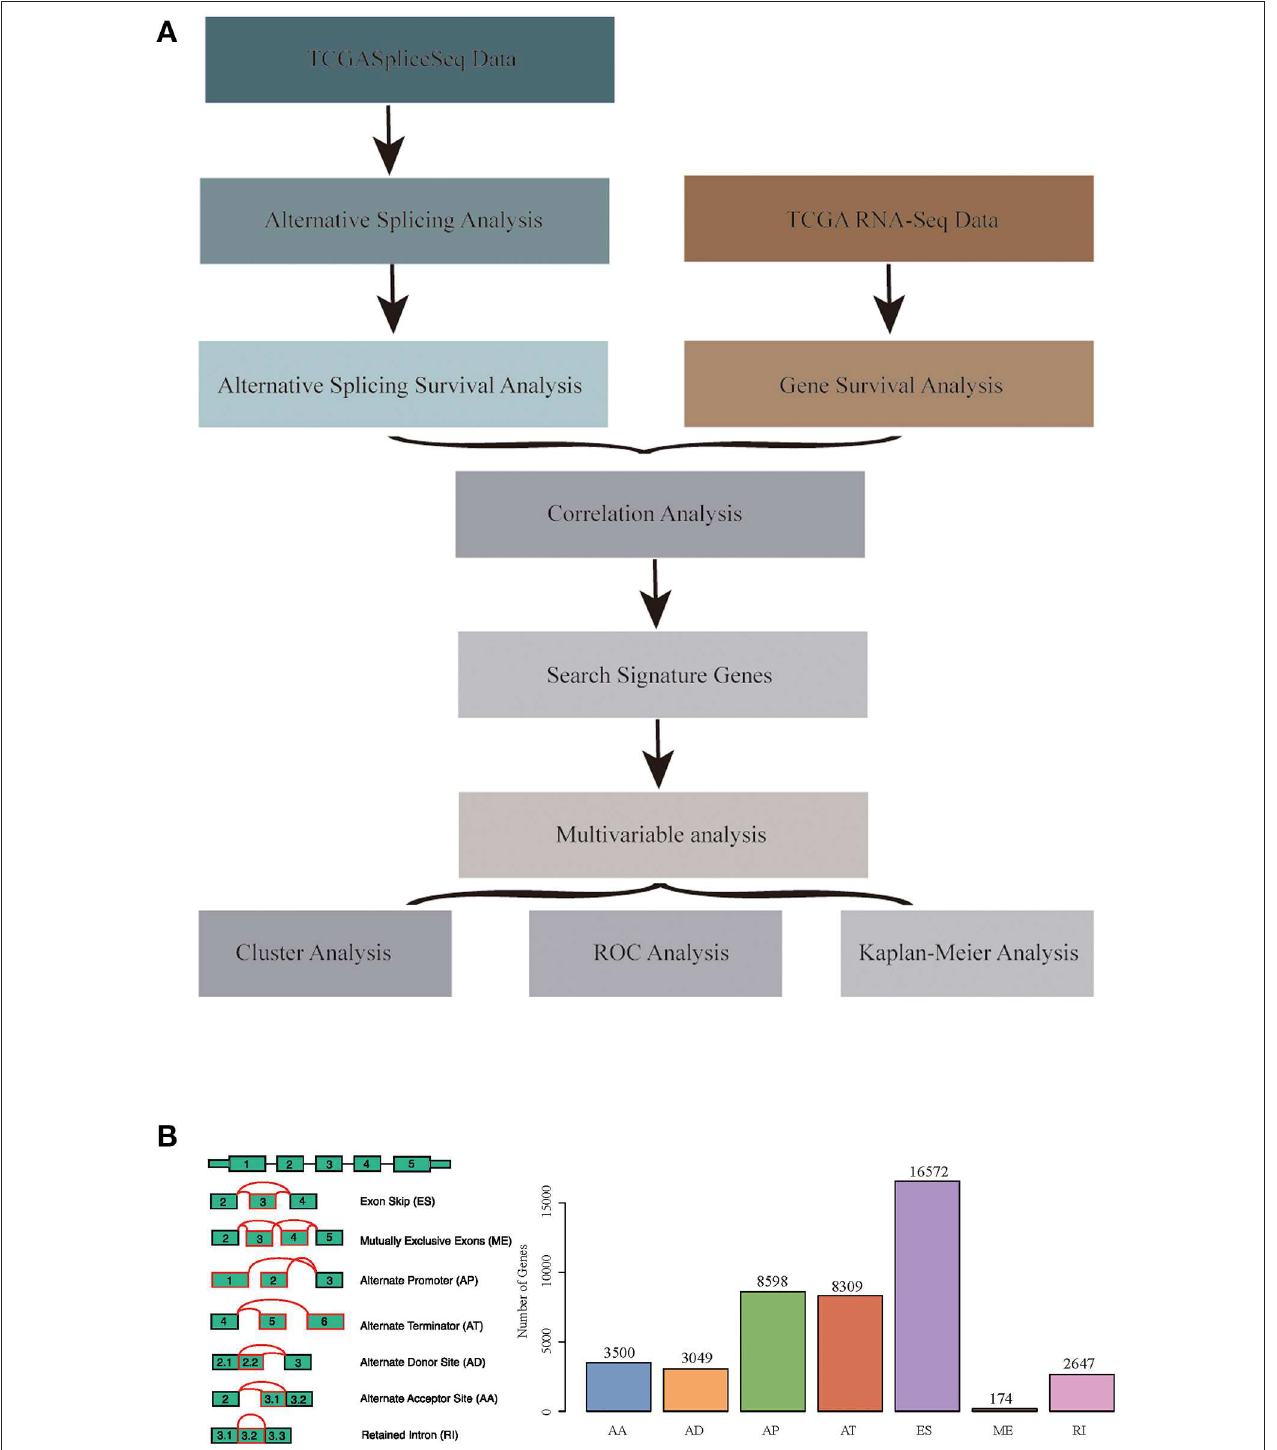
FIGURE 1 | (A) Schematic diagram of the research methodology. (B) Overview of seven types of alternative splicing (AS) events in this study. Illustrations for seven types of AS events: ES, Exon Skip; ME, Mutually Exclusive Exons; RI, Retained Intron; AP, Alternate Promoter; AT, Alternate Terminator; AD, Alternate Donor site; AA, Alternate Acceptor